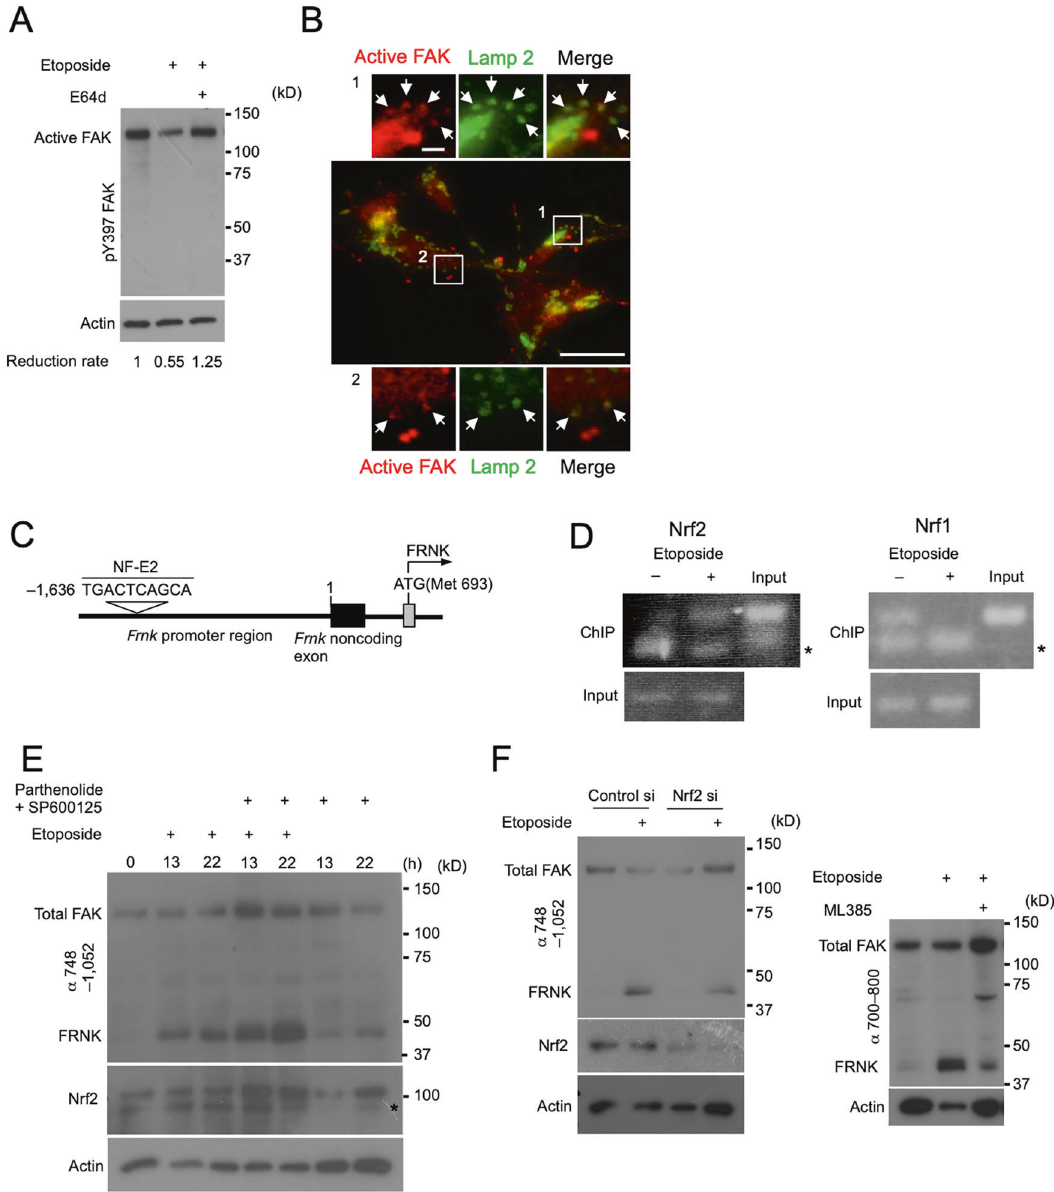
Fig. 5 Nrf2 drives the expression of FRNK upon genotoxic stress. A , B Bax / Bak -DKO MEFs were treated with etoposide (20 µM). A Immunoblot analysis demonstrating the suppression of etoposide-induced active FAK reduction by E64d (80 µg/mL), which is a broad lysosomal protease inhibitor. Band intensities of active FAK were normalized by actin used as a loading control, and the reduction rates are shown below the blots. B Immuno fl uorescence images showing the colocalization of active FAK and lamp2, a lysosome marker, by cotreatment with etoposide and E64d (80 µg/mL). Magni fi ed images of the boxed regions are shown in the top and bottom panels. Arrows indicate the colocalization of the two proteins. Scale bars, 30 µm (original image) and 10 µm (magni fi ed images). C Schematic diagram illustrating the area around the promoter region of the Frnk gene. The grey and black boxes indicate the exon containing the initiation codon of Frnk and the noncoding exon, respectively. The consensus NF-E2 binding sequence (the NF-E2 element), in which the fi rst nucleotide is located 1636 bp upstream of the transcription start site of the Frnk gene, is also indicated. D – F Bax / Bak -DKO MEFs were treated with etoposide (20 µM). D The ChIP assay demonstrating Nrf2 binding to the NF-E2 element in place of Nrf1 in an etoposide-dependent manner. Interaction of the indicated proteins with the NF-E2 element was electrophoretically analysed. Asterisks indicate nonspeci fi c bands. E Immunoblot analysis showing that the upregulation of Nrf2 by cotreatment with 5 µM parthenolide and 25 µM SP600125 coincided with the increase in the etoposide-induced expression of FRNK. The asterisk indicates nonspeci fi c bands. F Immunoblot analysis showing that the etoposide- induced expression of FRNK was diminished, owing to the reduced expression of Nrf2 by gene silencing (left panels) and by blockade of the nuclear translocation of Nrf2 with 20 µM ML385 (right panels). Actin was used as a loading control for all immunoblot experiments in this fi gure. epithelium. Microscopic observation revealed a sparse appearance mucosal layer was uneven, and a partial loss of the epithelial layer of the Frnk -KO epithelium (Fig. 6I), which resulted partially from was detected (Fig. 6E; bracket and 6G; asterisks). The muscularis gaps between the aligned epithelial cells (Fig. 6I, arrowheads). The mucosa was intact in the epithelium-depleted region (Fig. 6G; results of the histological analysis suggested that the epithelial white arrowheads), indicating that the damage was limited to the Cell Death and Disease (2023)